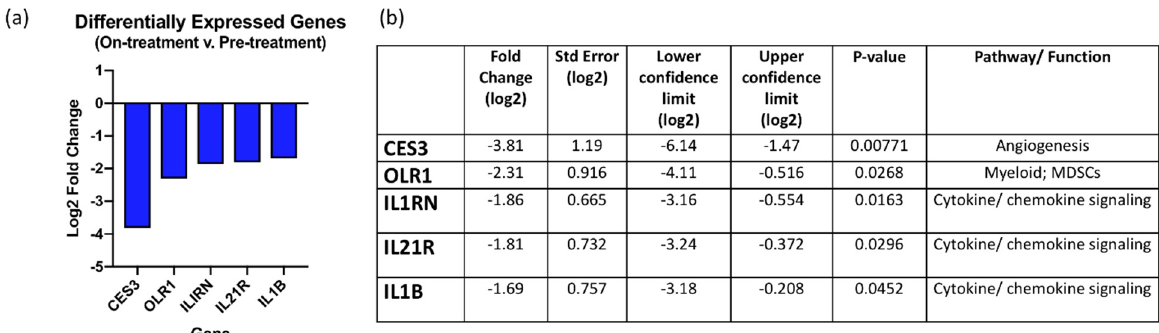
Figure 4. Effects of sotrastaurin and alpelisib on immune gene expression. ( a , b ) Gene expression analysis of immune-related genes was performed using the Nanostring IO360 Panel. Differentially expressed genes (on-treatment versus pre-treatment, n = 7 specimens per time-point) with log2 fold change >1.5 (and raw p -value < 0.05) are graphed and listed in the table ( b ). There were no genes demonstrating increased expression on-treatment compared to pre-treatment.